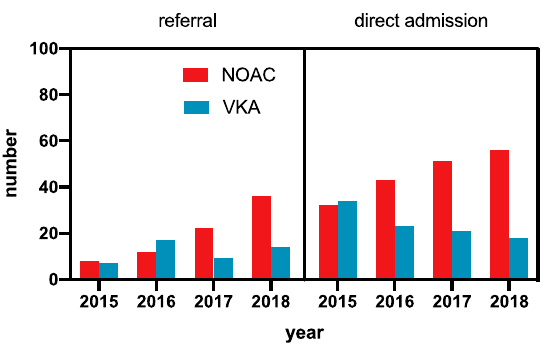
Figure 2. Admission time trend of patients with acute ischemic stroke and known AF and oral anticoagulation. VKA, vitamin K antagonist; NOAC, non-VKA oral anticoagulant. For 2018, data were extrapolated from the first half of the year.